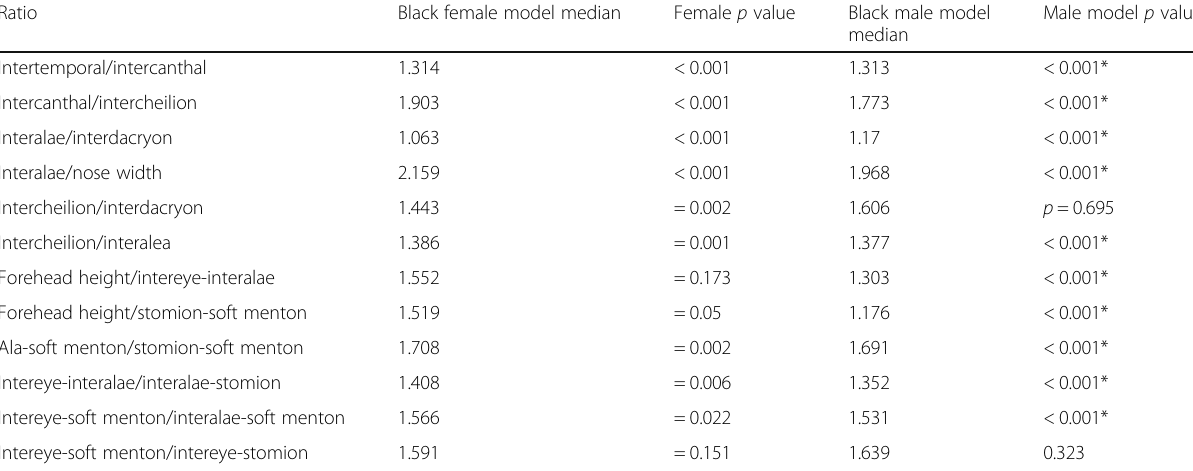
Male model p value median